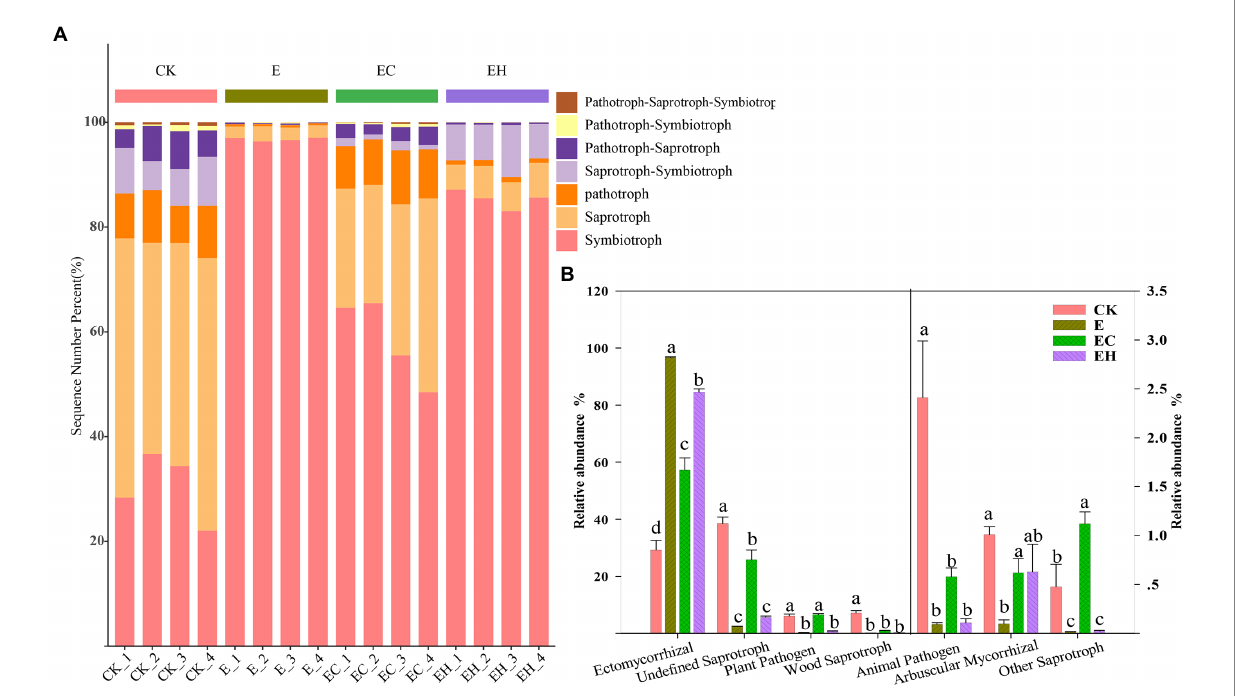
FIGURE 4 Soil fungal functional information inferred by FUNGuild in pure eucalypt plantations (CK, E) and mixed plantations (EC, EH). (A) Major trophic modes of soil fungi and (B) variation in the relative abundance of functional guilds (top 7) for each nutrient mode. CK, the first rotation of E. urophylla plantations; E, the third rotation of E. urograndis plantations; EC, mixed plantations of E. urograndis and Cinnamomum camphora ; EH, E. urograndis and Castanopsis hystrix